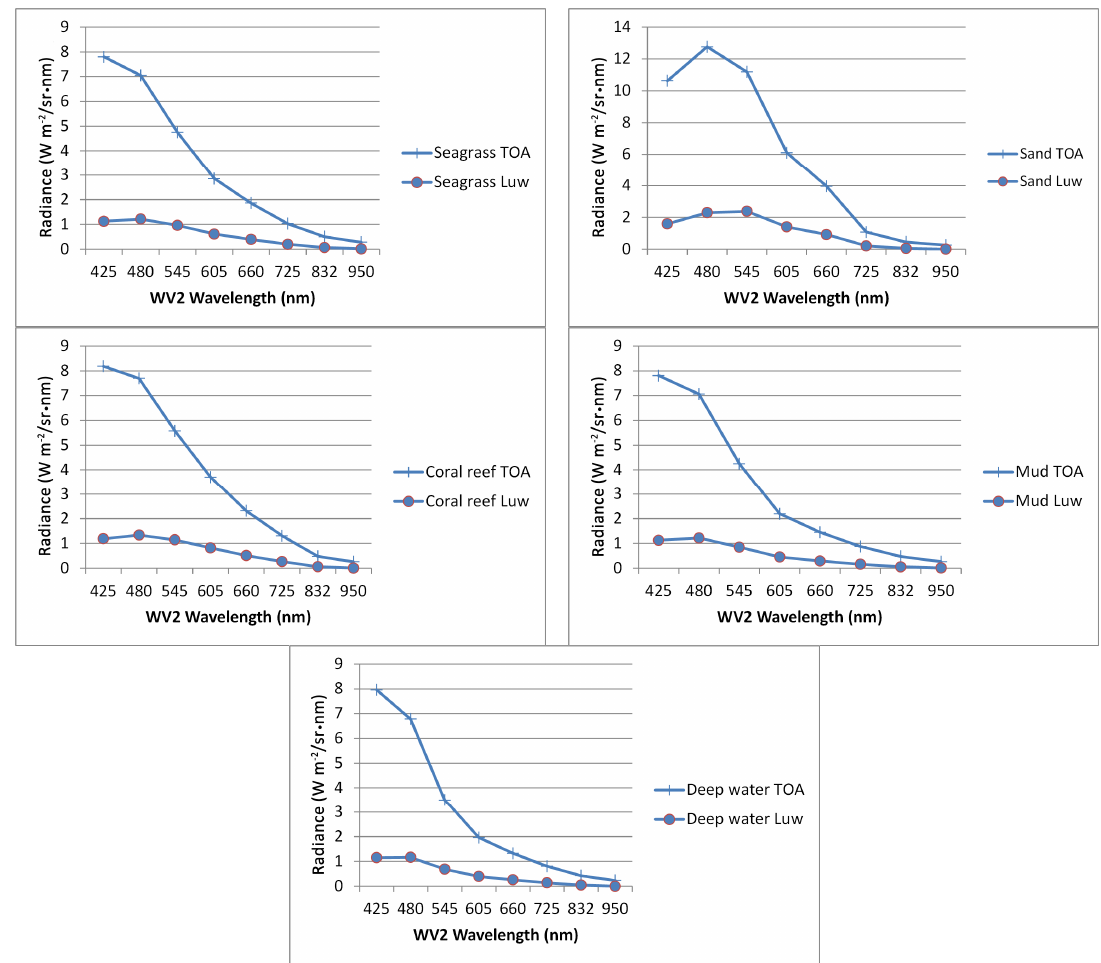
Figure 4. Comparison of top of atmosphere (TOA) and water leaving radiances (Luw) derived from WV2 image over different substrates that include seagrass, sand, coral reef, mud and deep water after the CSA atmospheric correction. Notice that the scale in the y ‐ axis of the sand graph is higher.